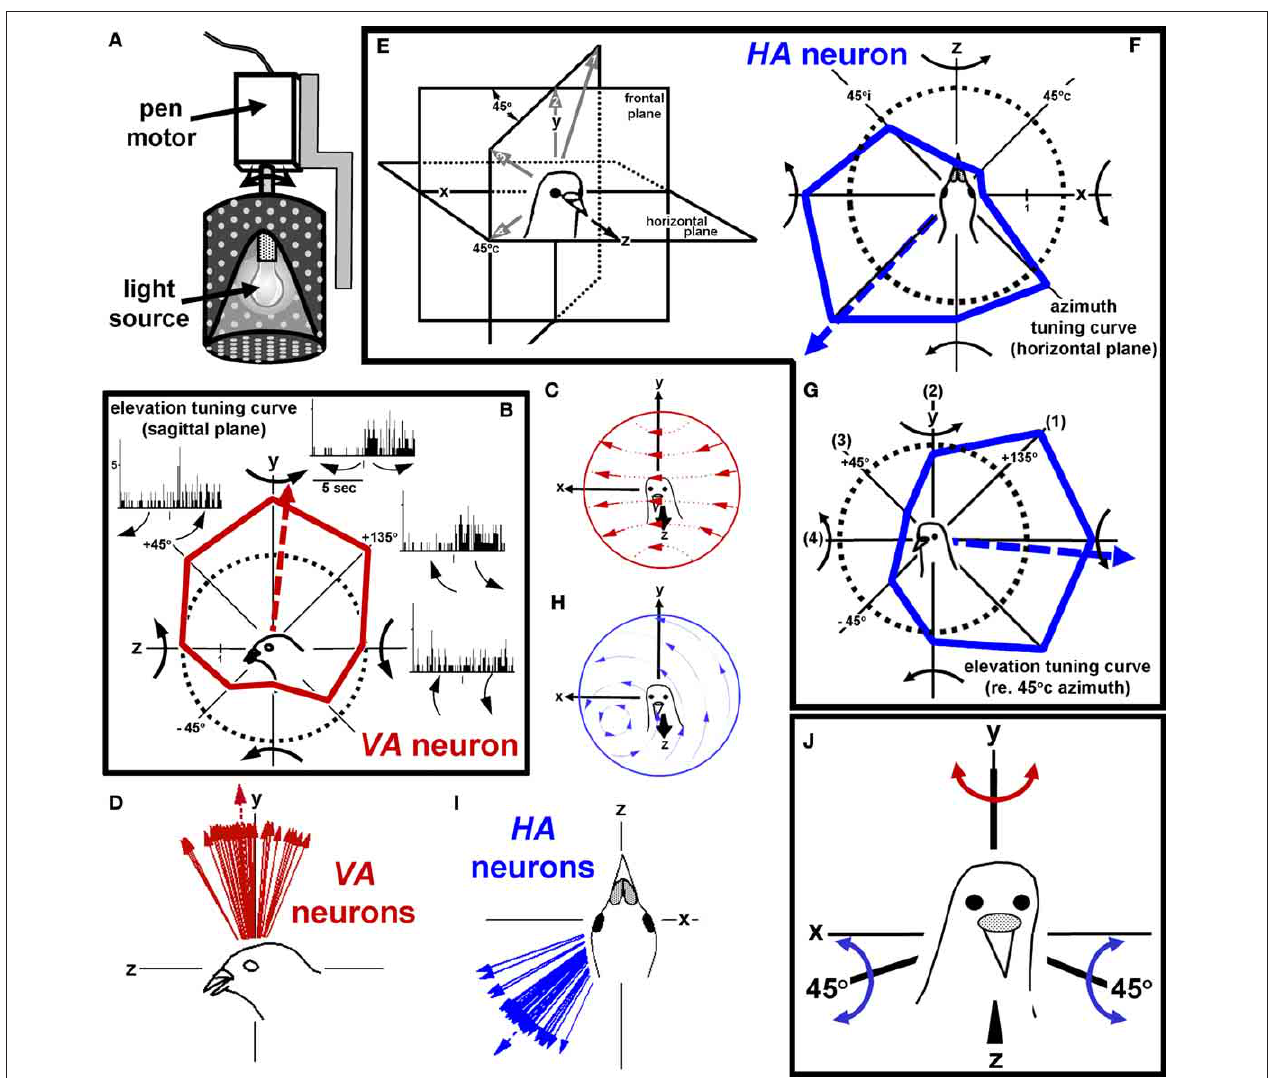
FIGURE 4 | Stimulating rotation-sensitive optic flow neurons in the pigeon vestibulocerebellum (VbC). (A) Shows a schematic of the planetarium projector used to simulate rotational optic flow. (B) Shows the elevation tuning curve for a vertical axis ( VA ) neuron. The flowfield that maximally stimulates VA neurons shown in (C) , and the best axes of several VA neurons are shown in (D) . (E–G) Shows axis tuning for an HA neuron. (F) Shows an azimuth tuning curve plotting the responses to rotation about axes in the horizontal ( xz ) plane. (G) Shows an azimuth tuning curve in a vertical plane that intersects the horizontal